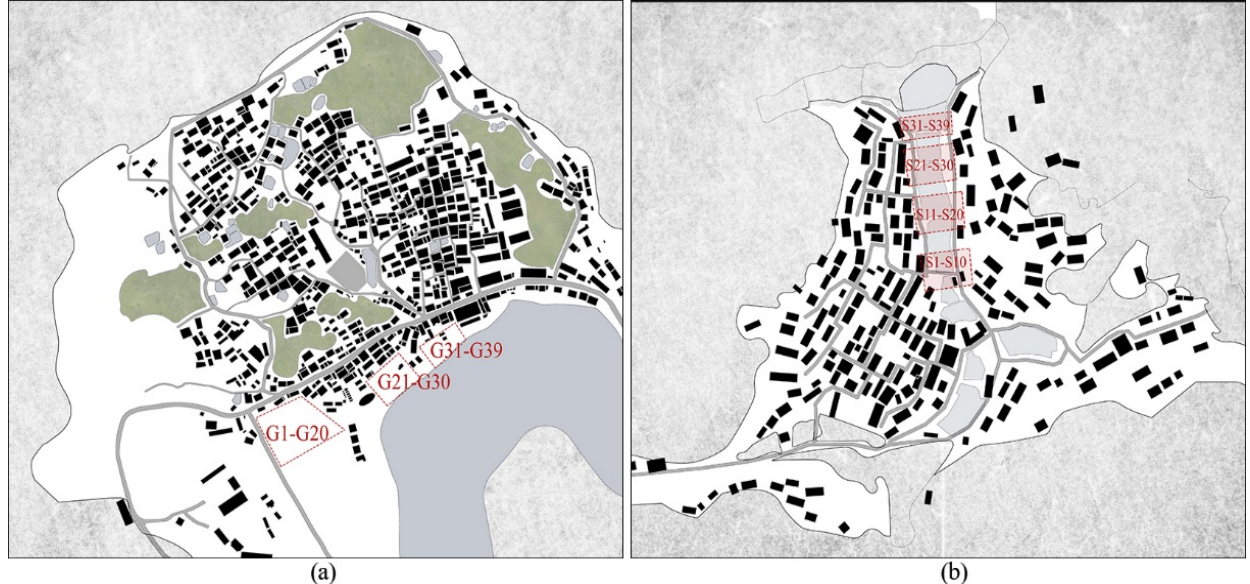
Figure 8. ( a ) The measurement points (G1–G39) of open-space windspeed in High chair Village; and ( b ) the measurement points (S1–S39) of open-space windspeed in Shujiatang Village.